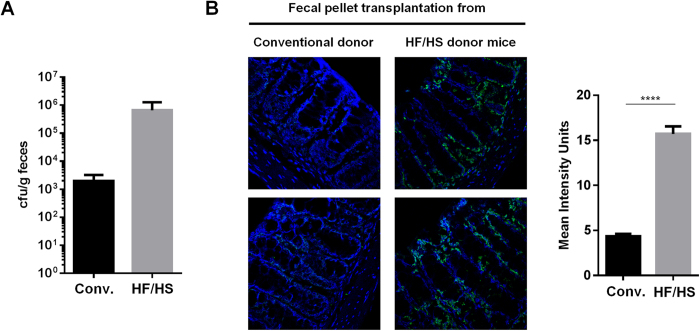
Western diet selects a colitogenic microbiota favoring AIEC colonization.(A) GF mice receiving a conventional or a HF/HS fecal transplantation were inoculated intragastrically with AIEC LF82. (A) Fecal counts of AIEC LF82 bacteria were performed (B) E. coli colonization of the colonic mucosa was compared between mice transplanted with a fecal pellet from conventional or HF/HS donor mice using confocal microscopy and quantification was performed using the ImageJ software. ****P < 0.0001.